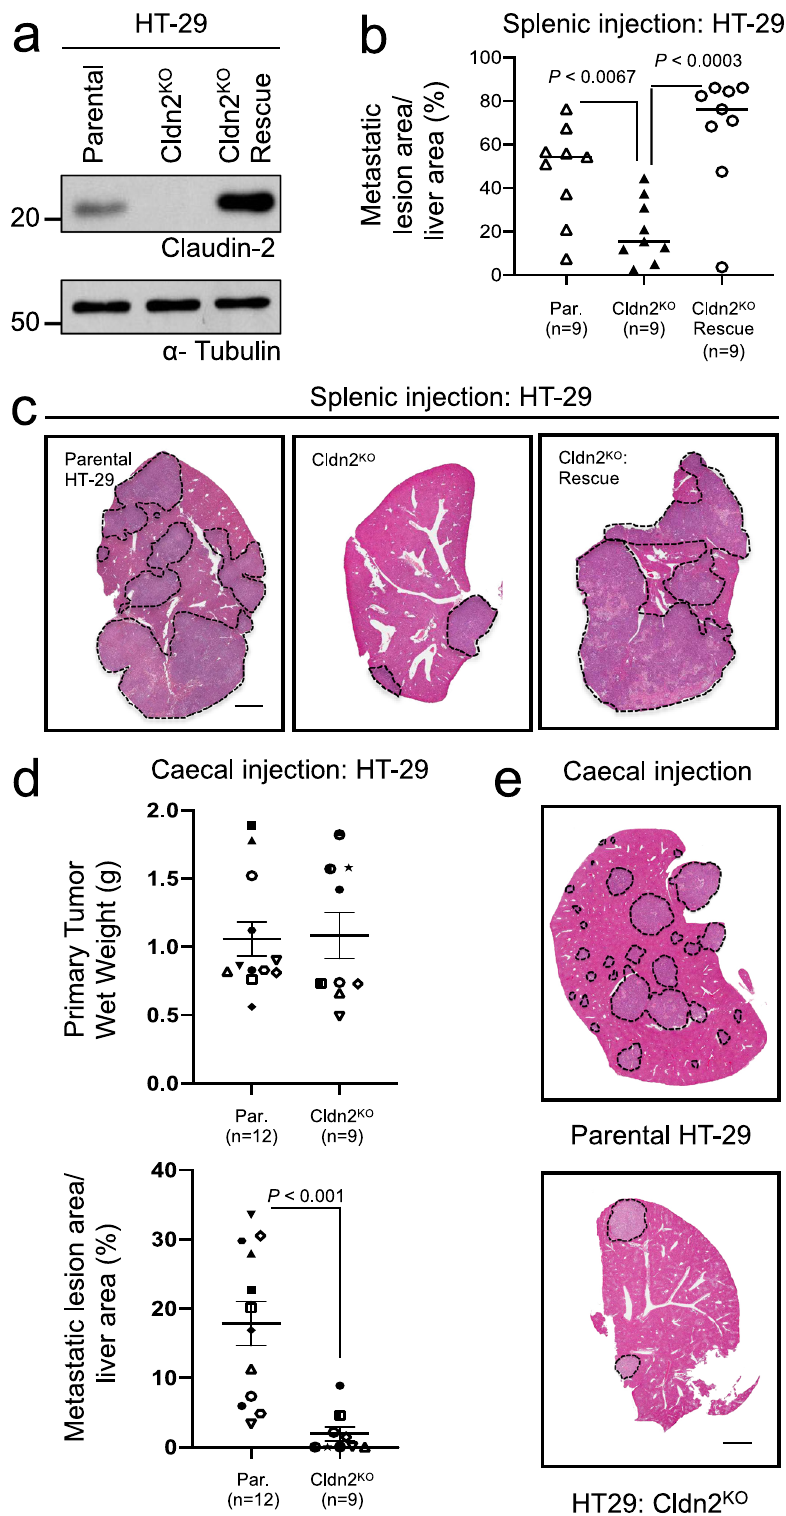
the the Δ PDZ BD mutant) (Supplementary Fig. 3b). Following splenic injection, mice receiving pooled populations expressing wild-type Claudin-2 (Cldn2 KO : WT, Cldn2 KO : HA-WT) developed signi fi cant and comparable metastatic burden (Fig. 1b; Supple- mentary Fig. 3c, d), whereas the cohort injected with Cldn2 KO : Δ PDZ BD expressing CRC cells exhibited reduced liver-metastatic burden (Supplementary Fig. 3c, d). The ability of wild-type